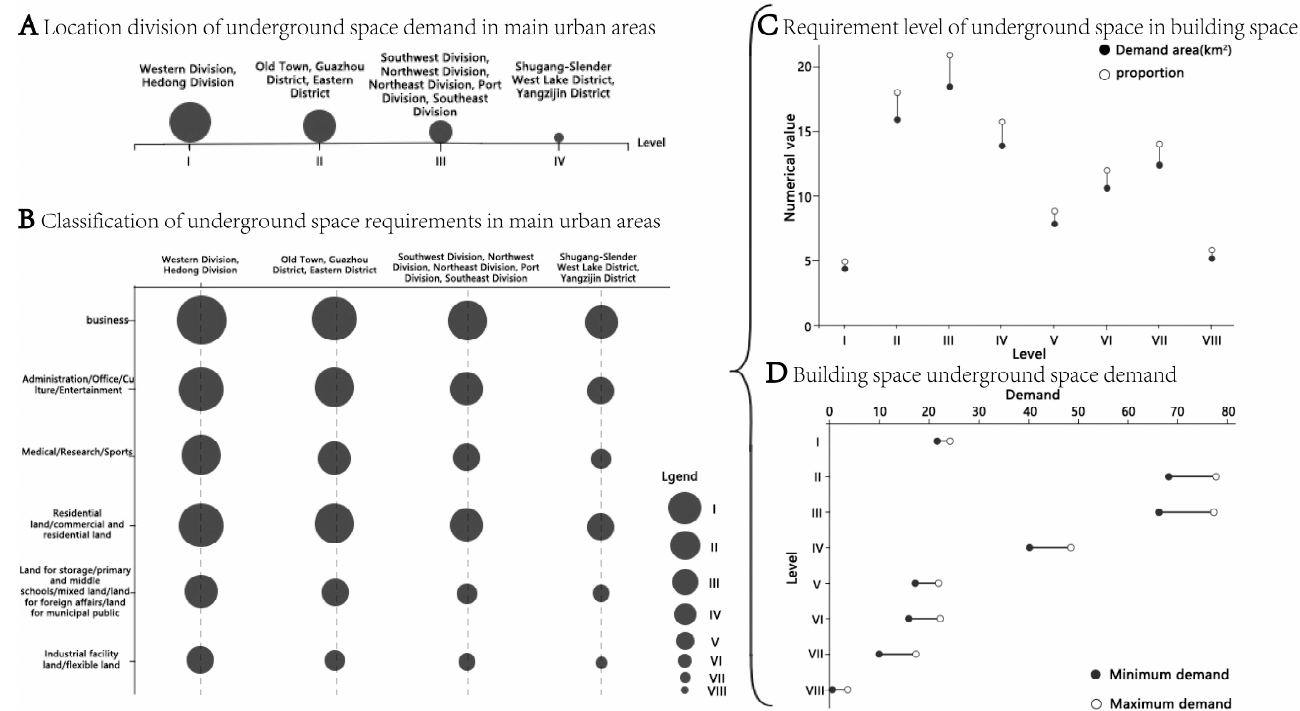
Figure 15. Underground space requirements of building space.